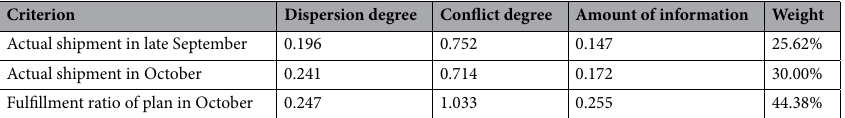
Table 2. The results of the CRITIC